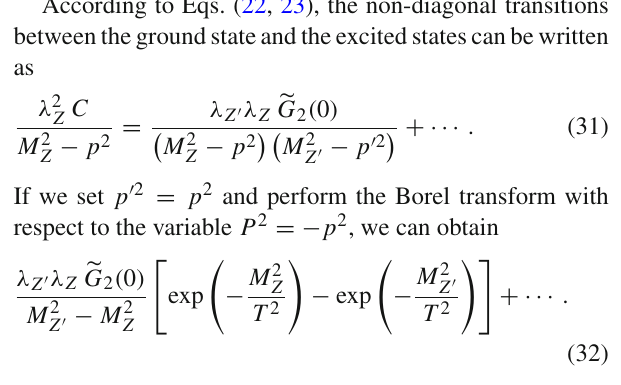
detailed QCD sum rules analysis of the photon light-cone distribution amplitudes [42].